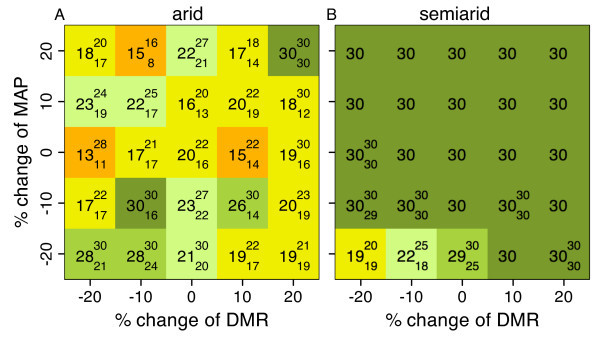
Persistence of populations in the arid and semiarid regions. Median persistence (yr) was observed in isolated 25 × 25 cm2 populations. Small numbers represent the lower and upper quartile if persistence of one or more populations was <30 years. Simulations were stopped after yr 30. Colour code: orange: 10–15 yr, yellow: 16–20 yr, pale green: 21–25 yr, light green: 26–29 yr, dark green: 30 yr.